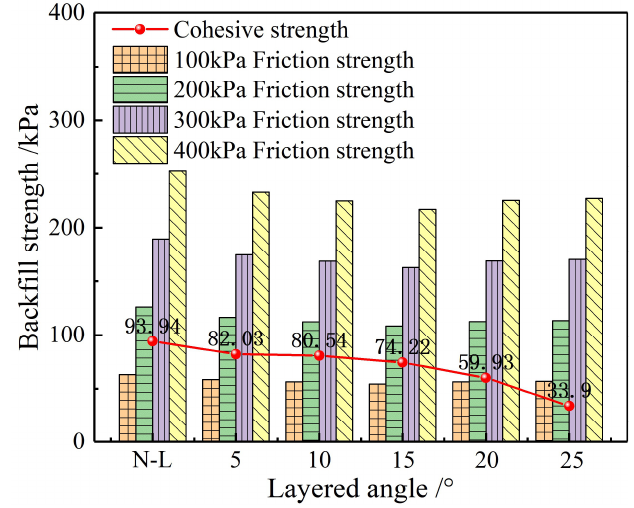
Figure 12. Analysis of shear strength mechanism.